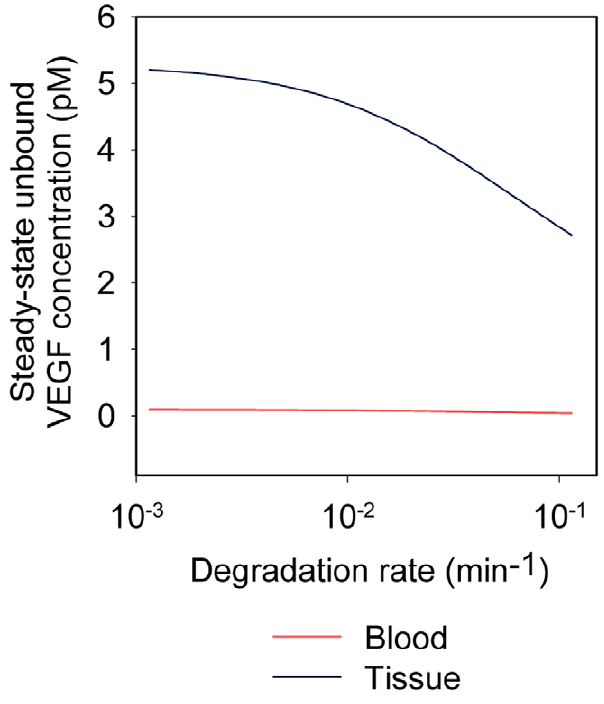
Figure 11. Effect of VEGF degradation on unbound VEGF levels. A VEGF degradation rate constant of 1.16 6 10 2 2 min 2 1 (corresponding to half-life of 60 minutes) in the normal tissue was added before re-performing the estimation of the free parameters. Using the new set of optimized parameter values, the steady-state concentrations of unbound VEGF were calculated as the degradation rate was varied. The concentration of unbound VEGF in the normal tissue decreases as the degradation rate